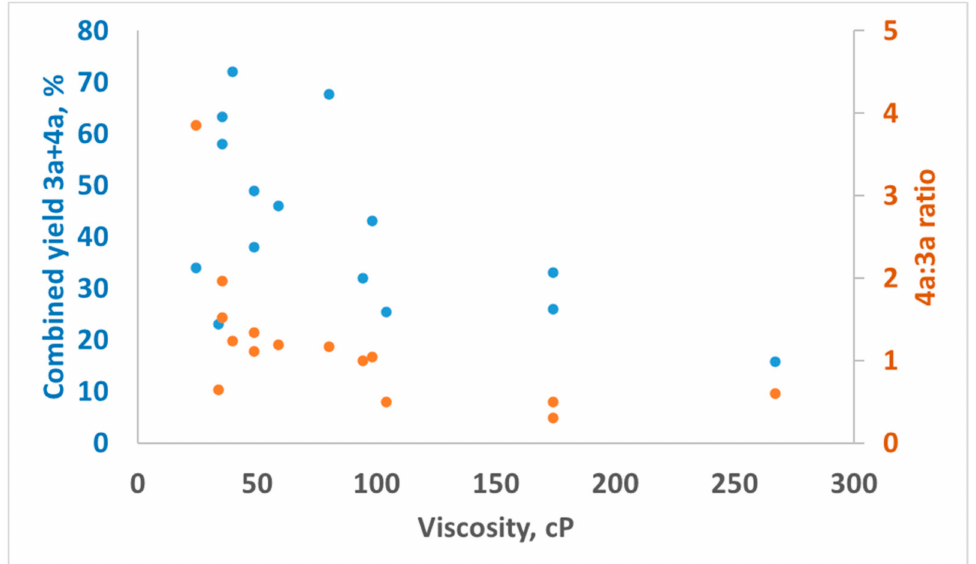
Figure 2. Effect of viscosity of grinding additives on the electrophilic fluorination of